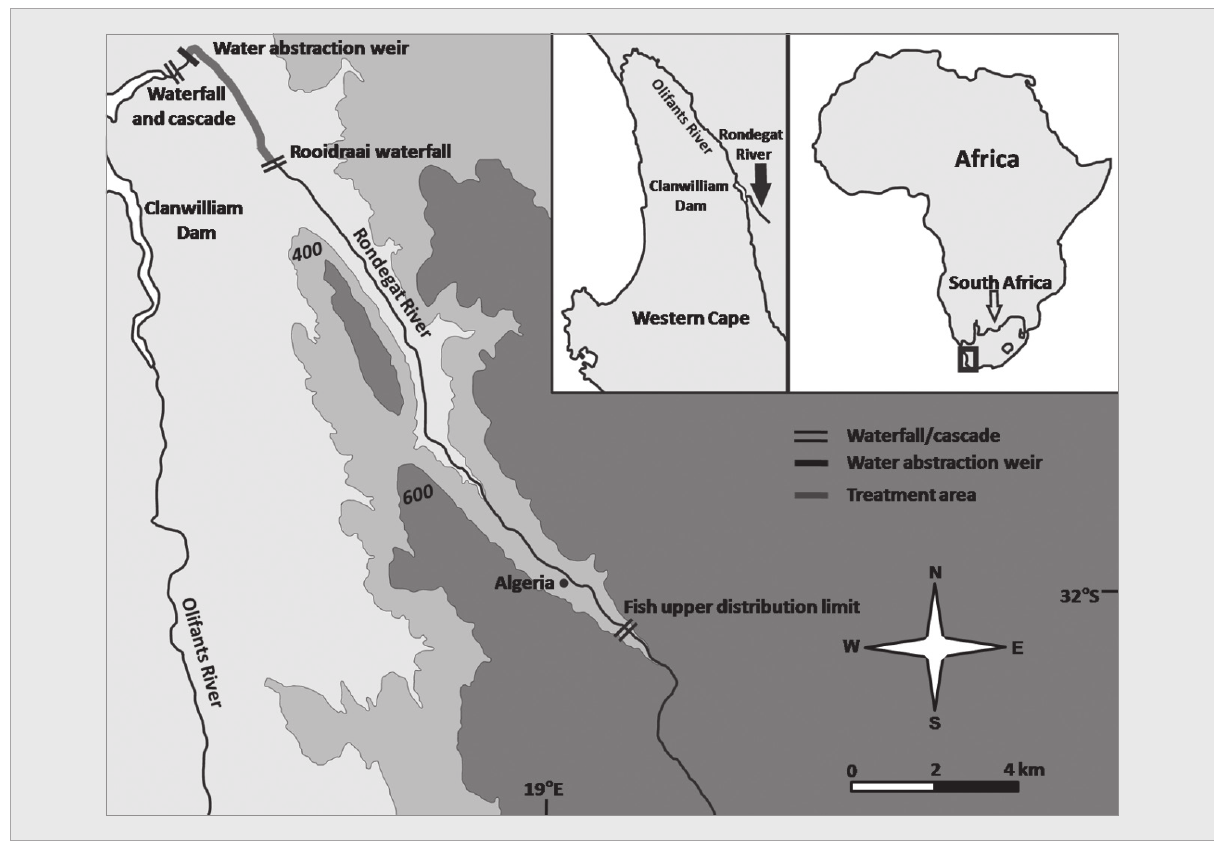
Source: Weyl et al. 13 Shadings represent 200-m contours.